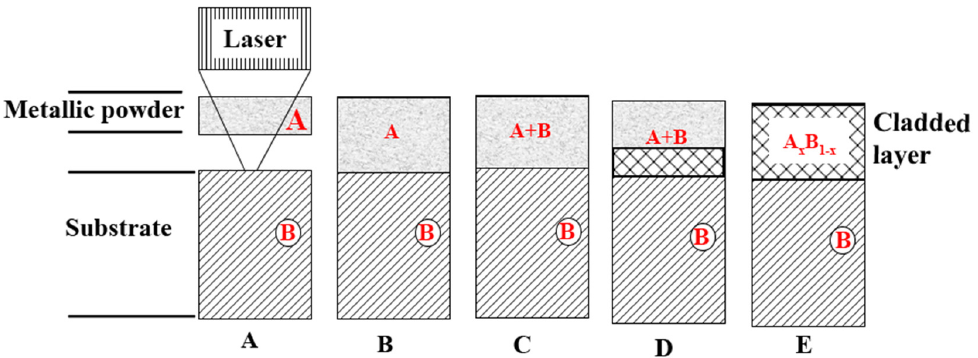
Figure 7. Laser surface–cladding steps [3].